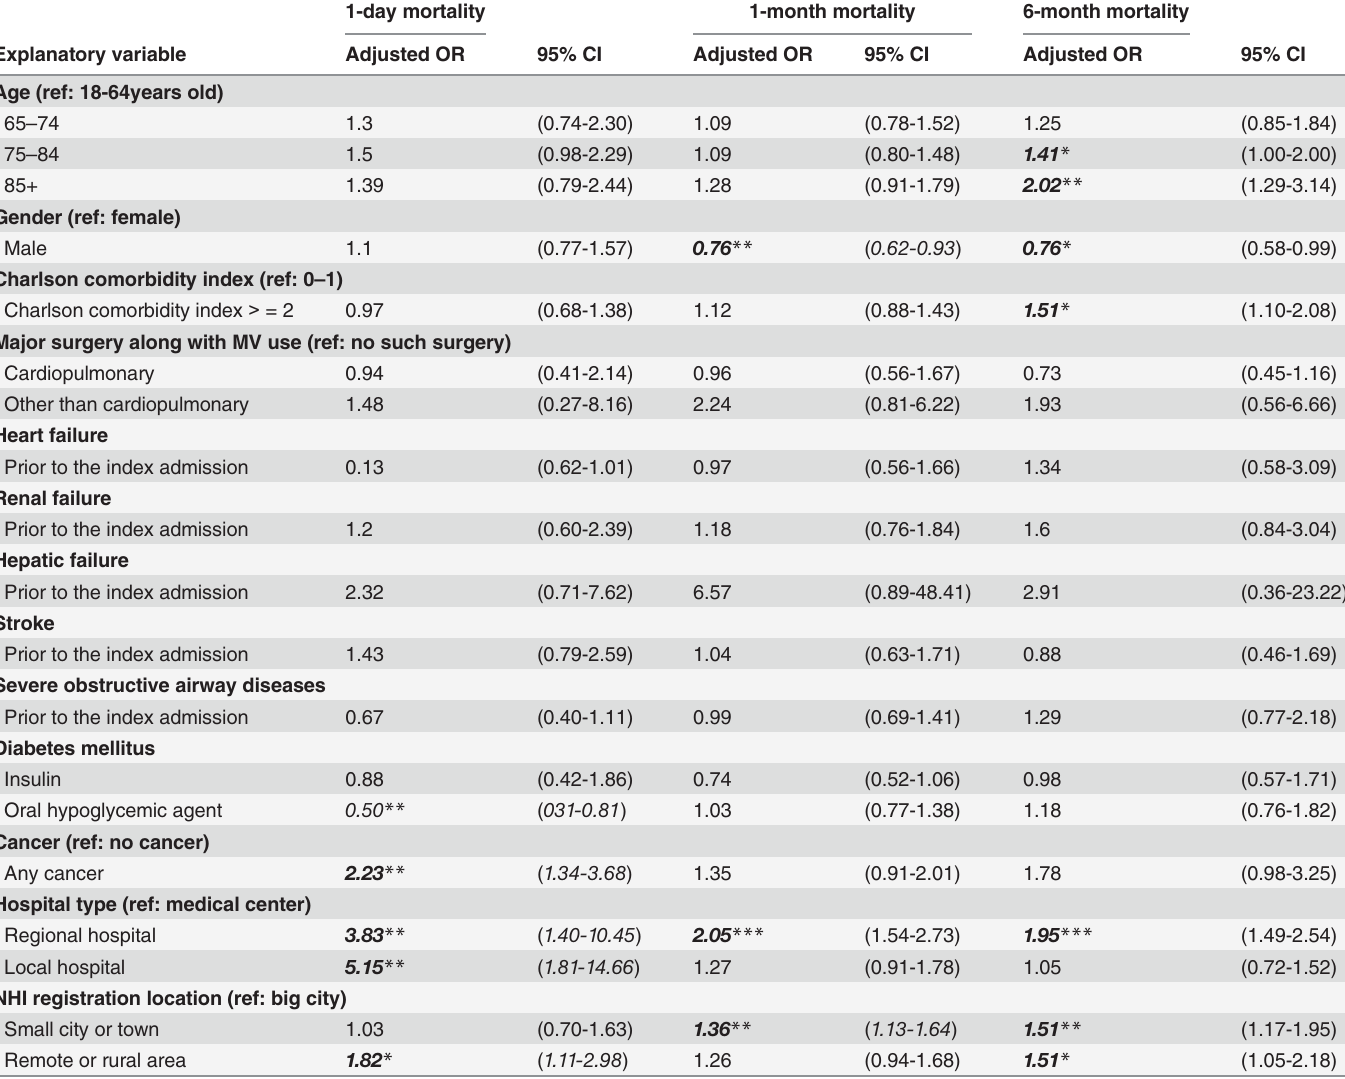
Table 6. Factors associated with 1-day, 1-month and 6-month mortality rates among OHCA patients requiring MV care during the hospital stay: lo- gistic regression models that adopt a robust variance estimator adjusting for hospital-level intra-group